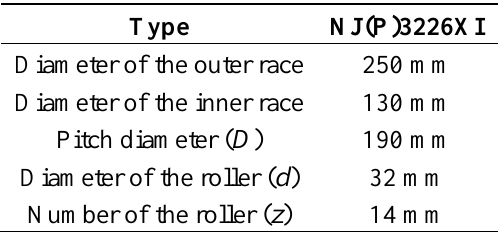
Table 1. Specifications of the testing bearing.